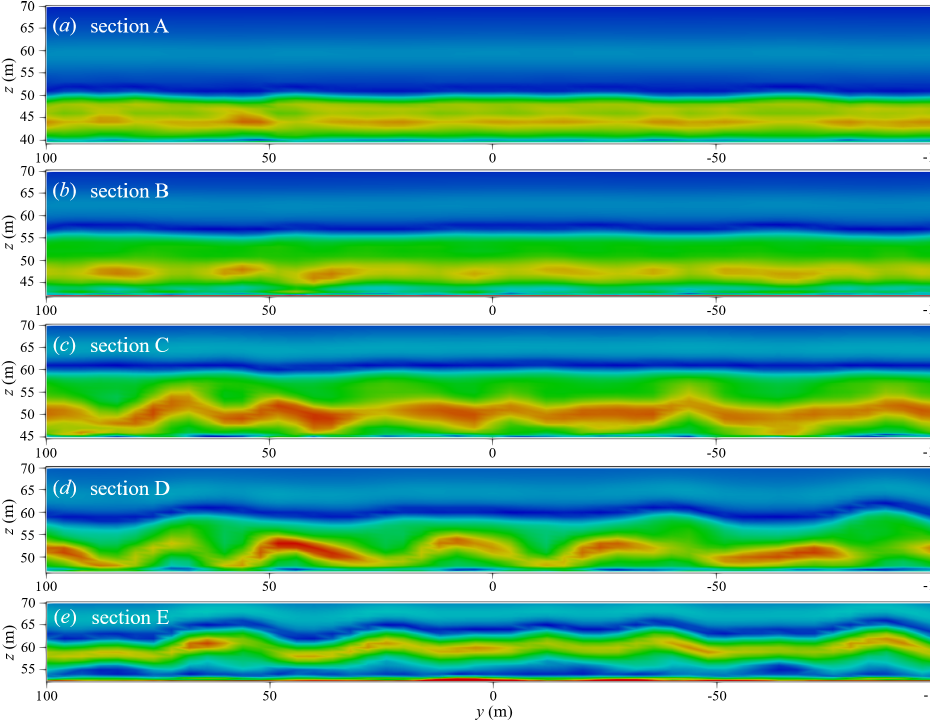
Figure 23. Vorticity field of transverse sections.